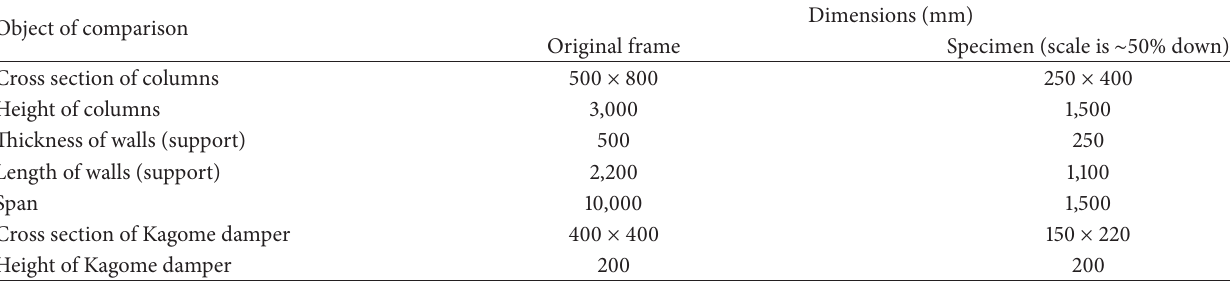
Table 3: Comparison of dimensions between the existing original frame and scaled-down specimen for structural tests.